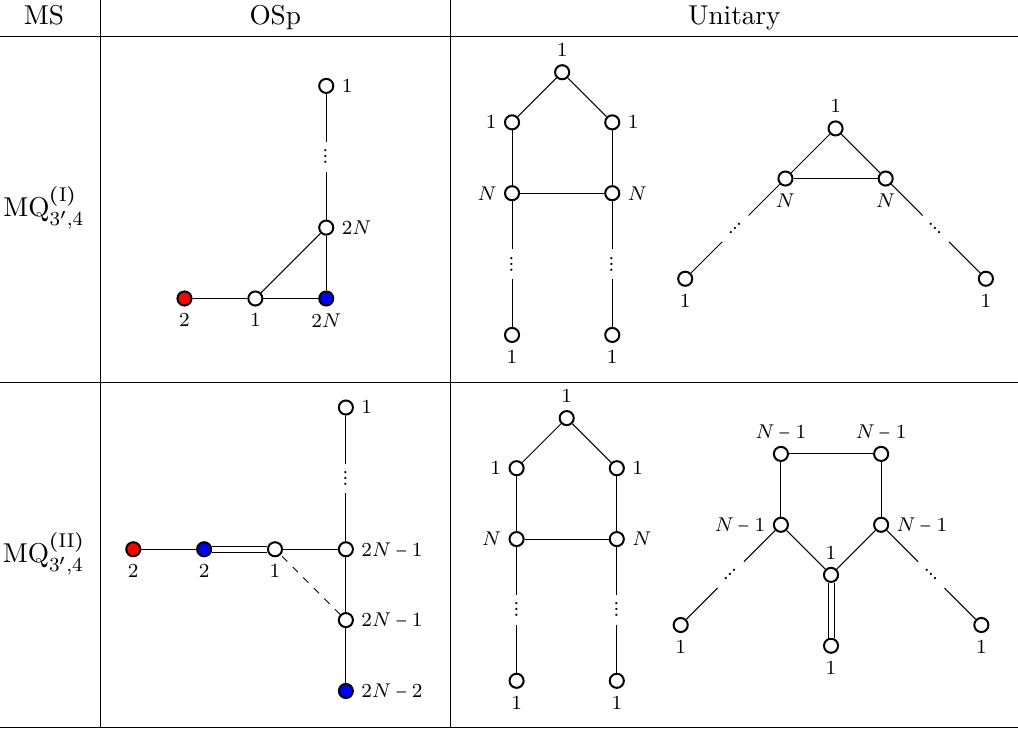
Table 5. Magnetic quivers for the two cones of the Higgs branch of EQ